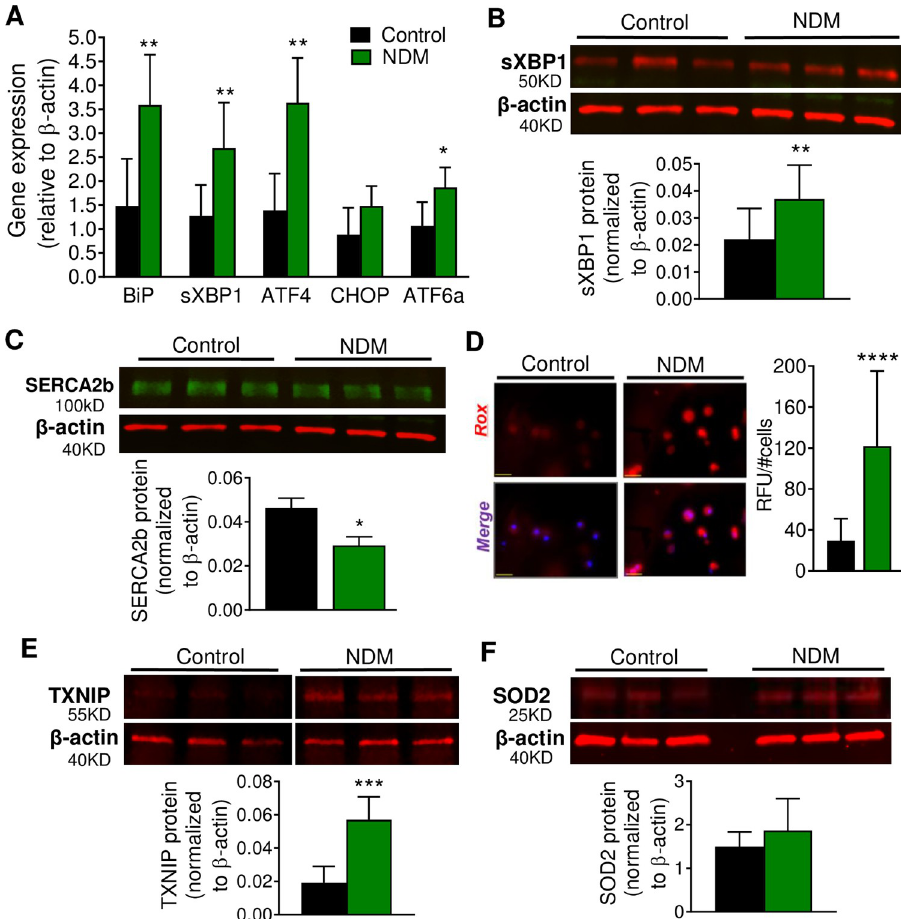
Fig 2. NDM islets demonstrated oxidative and ER stress in early diabetes (A) Quantitative real-time PCR analysis of gene expression of ER stress markers in islets (n = 7–9 mice/group). Western blot analysis of (B) sXBP1 and (C) SERCA2b, representative blot (top) and quantification (bottom) (n = 6 mice/group). (D) Reactive Oxygen Species (ROS) measurement in dispersed islets; representative images (left) and quantification (right) (n = 18 images from islets obtained from 3–4 mice in each group; scale bar = 25 μ m). (E) Representative western blot of TXNIP (top) and quantification (bottom) (n = 6 mice/group). Samples were run on the same gel but were not contiguous. (F) Representative western blot of SOD2 (top) and quantification (bottom) (n = 6 mice/group). Black = controls and green = NDM at day 15 post tamoxifen induction. Data are expressed as mean ± SD Significant differences � P < 0.05, �� P < 0.01, ��� P < 0.001, ���� P <